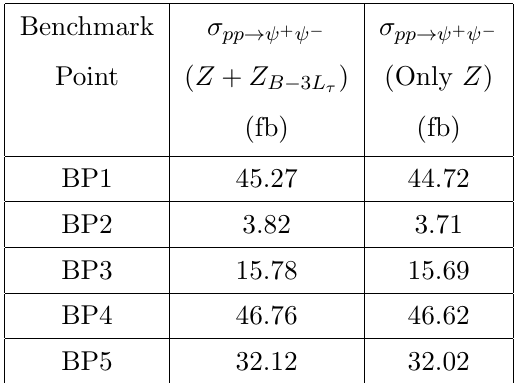
Table 3 . Production cross-section of charged VLF pairs for the chosen BPs in table 2 in presence of Z B (cid:0) 3 L (left column) and in presence of only SM Z (right (cid:28)